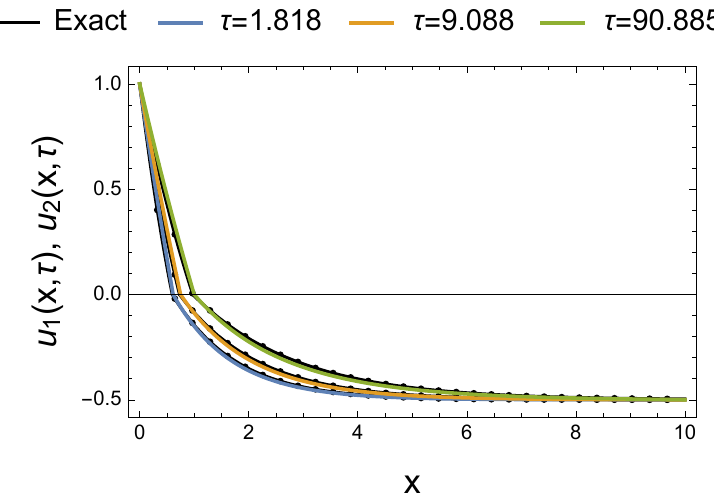
Figure 6. Numerical solution of u 1 , u 2 for α = 0.25, λ 1 = 1, λ 2 = 2, κ 1 = 1, κ 2 = 1.